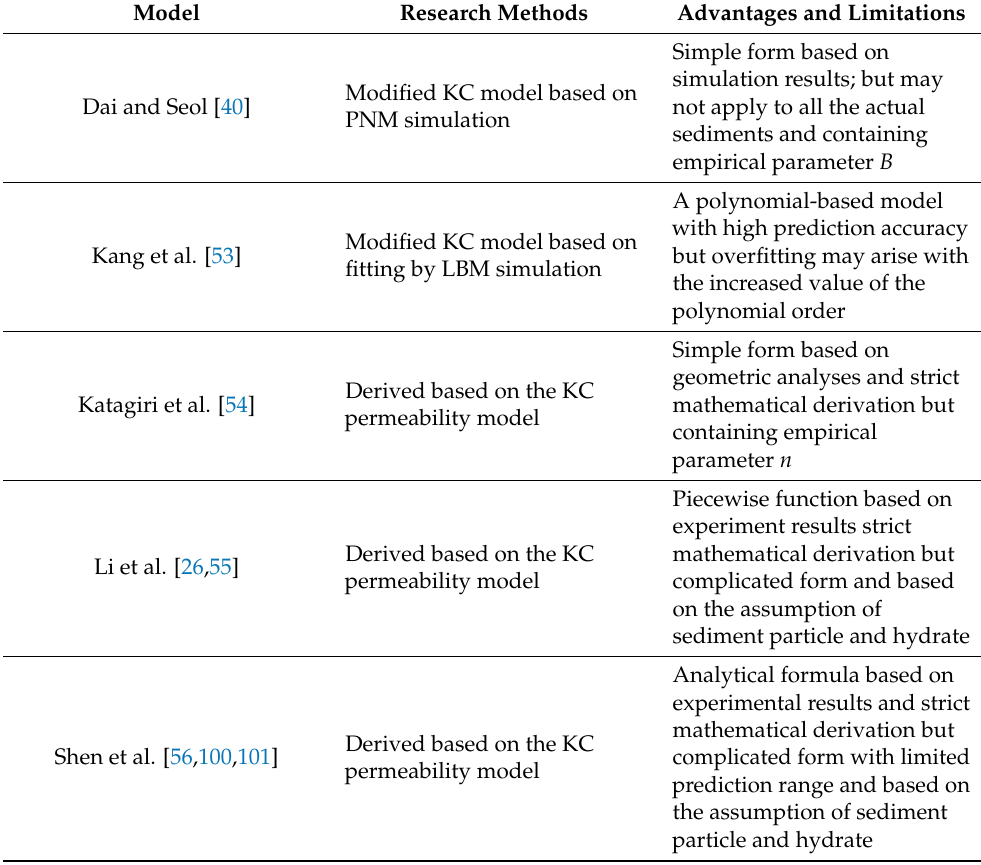
Table 5. Research methods, advantages, and limitations of modified permeability models for perme- ability prediction of